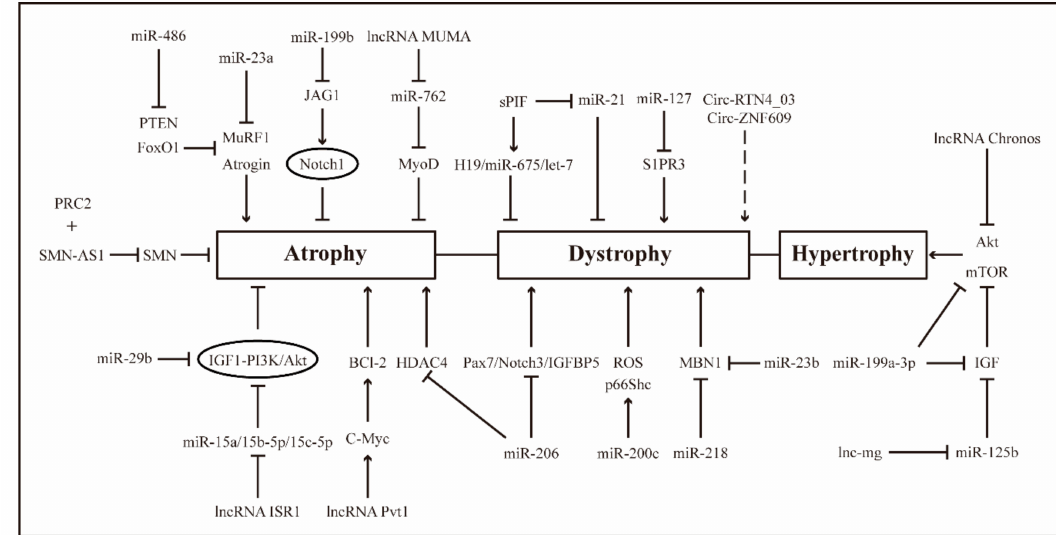
Figure 2. ncRNAs regulate muscle diseases such as dystrophy, atrophy and